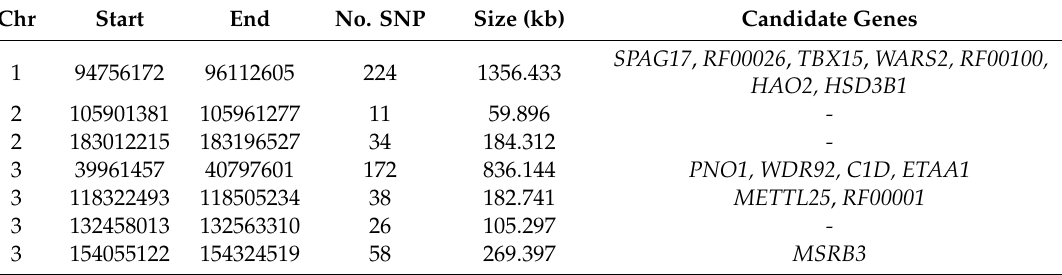
Table 2. Genes located in genomic regions showing evidence of